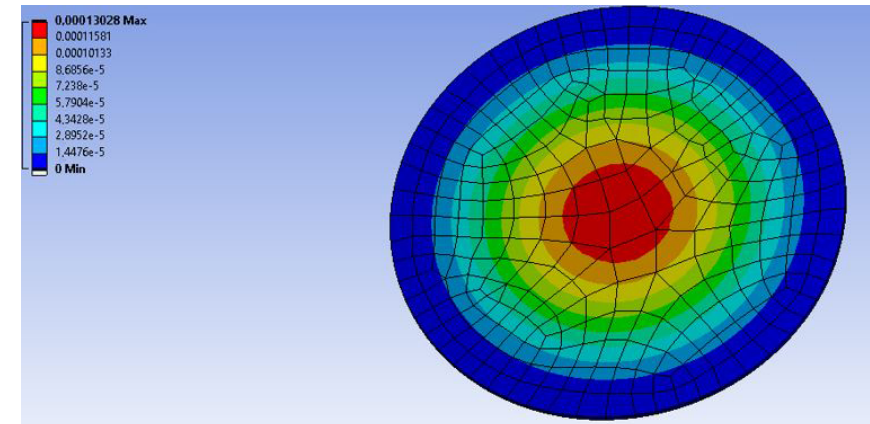
Figure 3. Finite element simulation of the printed membrane, showing a maximum deflection at the center equal to 130µm at 9KPa.